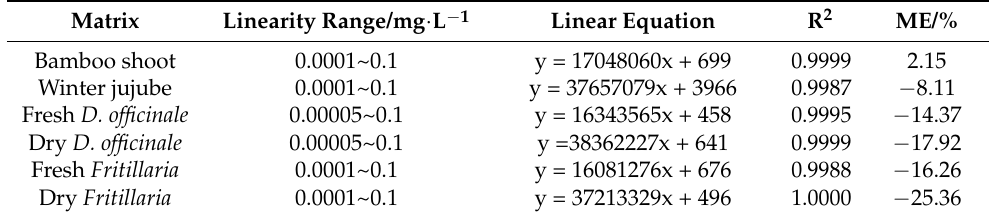
Table 1. Linearity range, linear equation, regression coefficient (R 2 ), and matrix effect (ME)